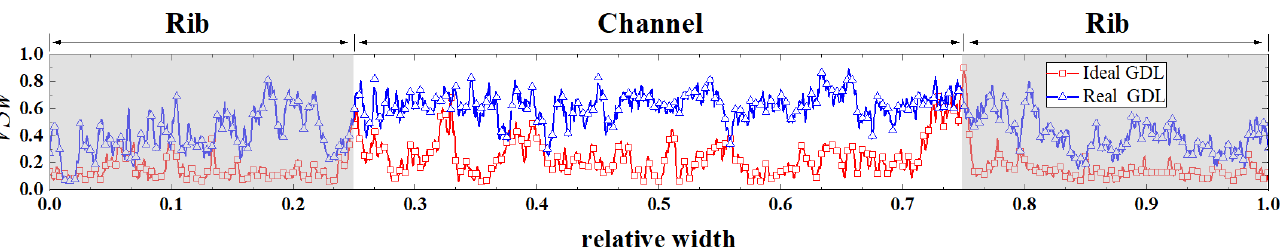
Figure 5. VS w of real GDL and ideal GDL in the thickness direction.